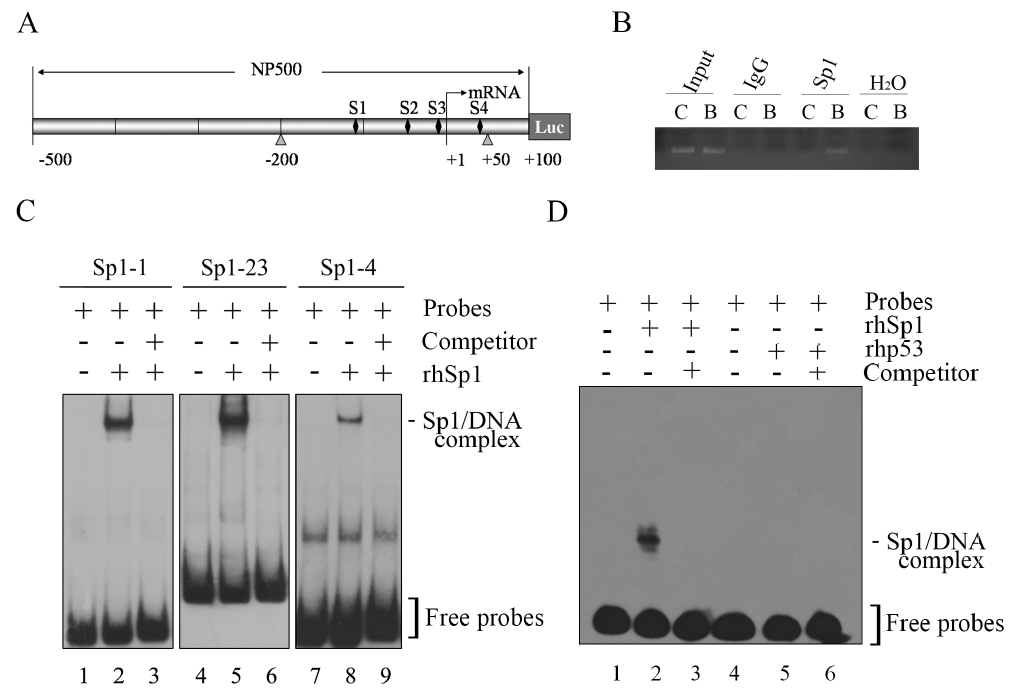
Figure 3. Sp1 Binds to the RLIM Promoter both inVitro and inVivo . ( A ) Schematic representation of the RLIM promoter region in NP500-Luc. The four putative Sp1 binding sites S1 to S4 (denoted as the solid bar X ) are shown. The arrow indicates the transcription start site. The triangles mark the flanking sites of the PCR fragment amplified in the ChIP assays (–200 bp to + 50 bp). ( B ) ChIP analysis for the binding of endogenous Sp1 to the RLIM promoter. Chromatin immunoprecipitations (ChIP) were performed with antibodies against either IgG as control or Sp1. DNA recovered from immunocomplexes were subjected to PCR using primers flanking Sp1 binding region, or primers corresponding to irrelevant upstream chromatin region. PCR was performed without chromatin as negative control (B, primers corresponding to binding region. C, primers corresponding to irrelevant upstream chromatin region). ( C ) EMSA analysis of the binding of Sp1 to the RLIM promoter in vitro . EMSA was performed using DIG-labeled PCR fragments of the RLIM promoter containing each putative Sp1 binding site as indicated. DIG labeled probes were incubated in binding reactions in the presence or absence of 150 ng rhSp1 protein (Promega). Lanes 1, 4 and 7: probes only. Lanes 2, 5 and 8: rhSp1 + probes. Lanes 3, 6 and 9: rhSp1 + probes + 50-fold excess cold unlabeled competitor DNA. Bands for the Sp1/DNA complexes and free probes are indicated. ( D ) EMSA analysis of the binding of Sp1 or p53 to the RLIM promoter region using the LightShift Chemiluminescent EMSA Kit. Lanes 1, 4 : Biotin-labeled probes only. Lane 2: rhSp1 + Biotin-labeled probes. Lane 3: rhSp1 + Biotin-labeled probes + 50-fold excess cold unlabeled competitor DNA. Lane 5: rhp53 + biotin- labeled probes. Lane 6: rhp53 + biotin-labeled probes + 50-fold excess cold unlabeled competitor DNA.